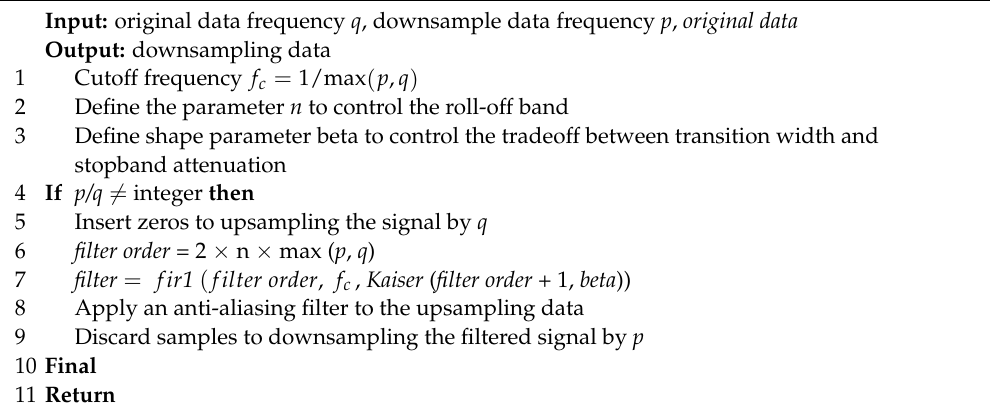
Algorithm 1: Design Kaiser window to approximate the anti-aliasing